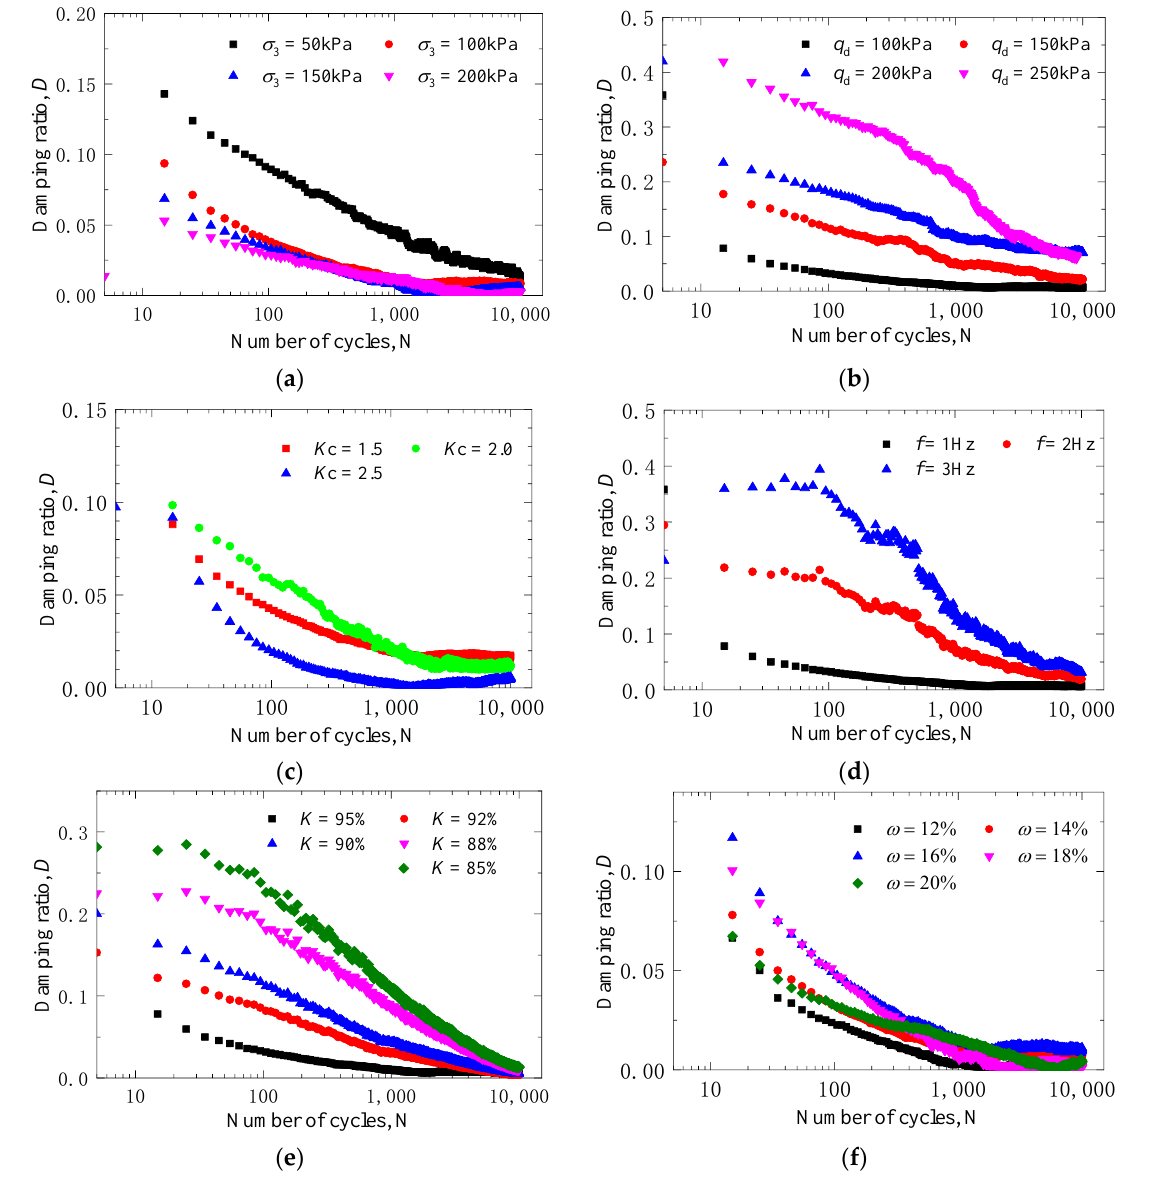
Figure 6. Damping ratio under different test conditions. ( a ) Damping ratio versus number of cyclic loading under different confining pressures. ( b ) Damping ratio versus number of cyclic loading under different loading amplitudes. ( c ) Damping ratio versus number of cyclic loading under different K c . ( d ) Damping ratio versus number of cyclic loading under different loading frequencies. ( e ) Damping ratio versus number of cyclic loading under different densities, K . ( f ) Damping ratio versus number of cyclic loading under different moisture